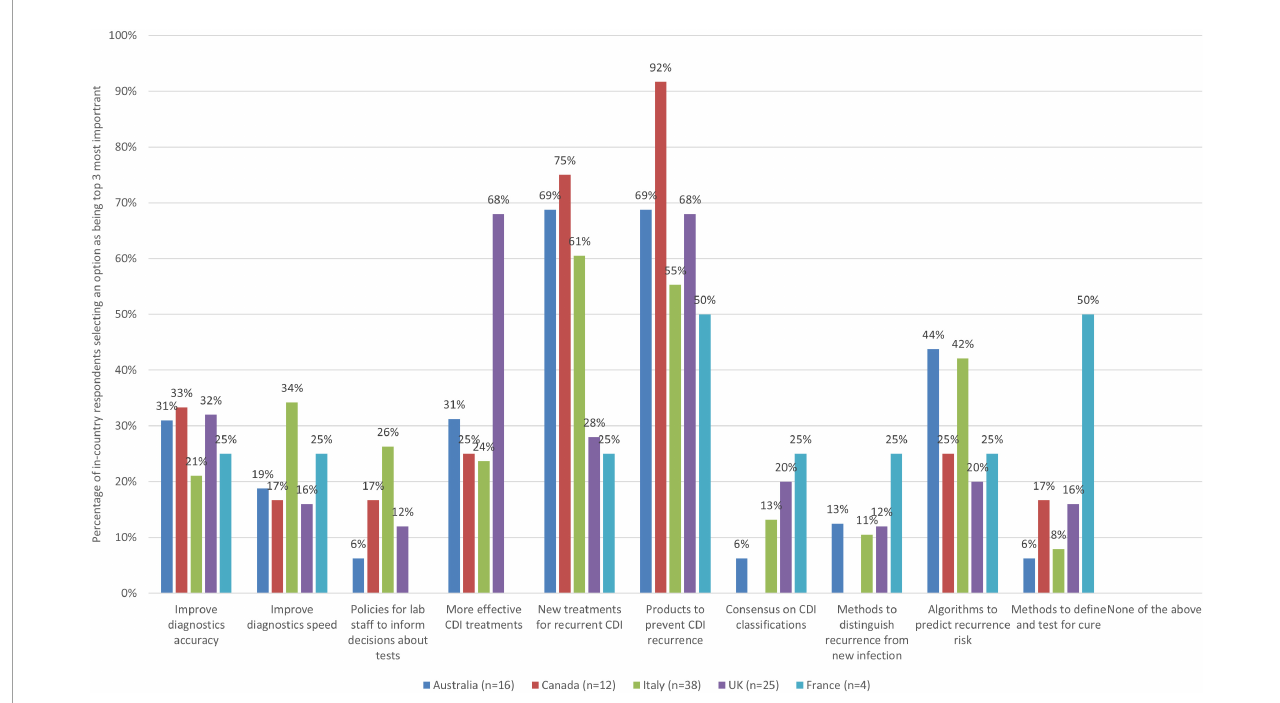
FIGURE1 The improvement actions related to diagnosis and treatment of CDI that are the most important (bars represent the percentage of respondents that rated each improvement action as one of the most important by